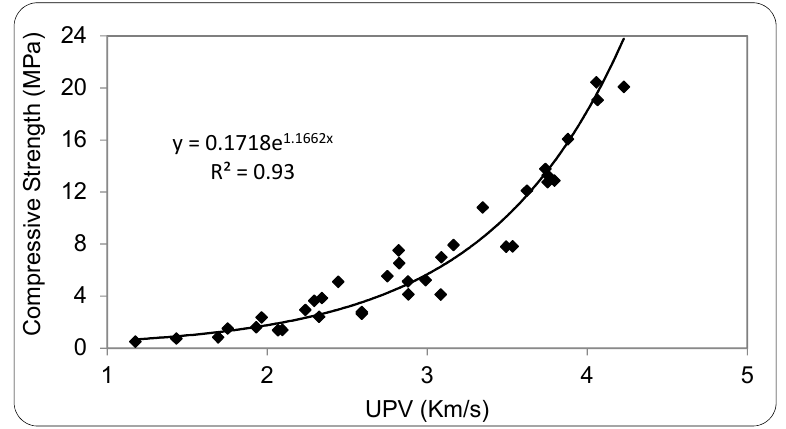
Figure 12. Correlation between strength and UPV.